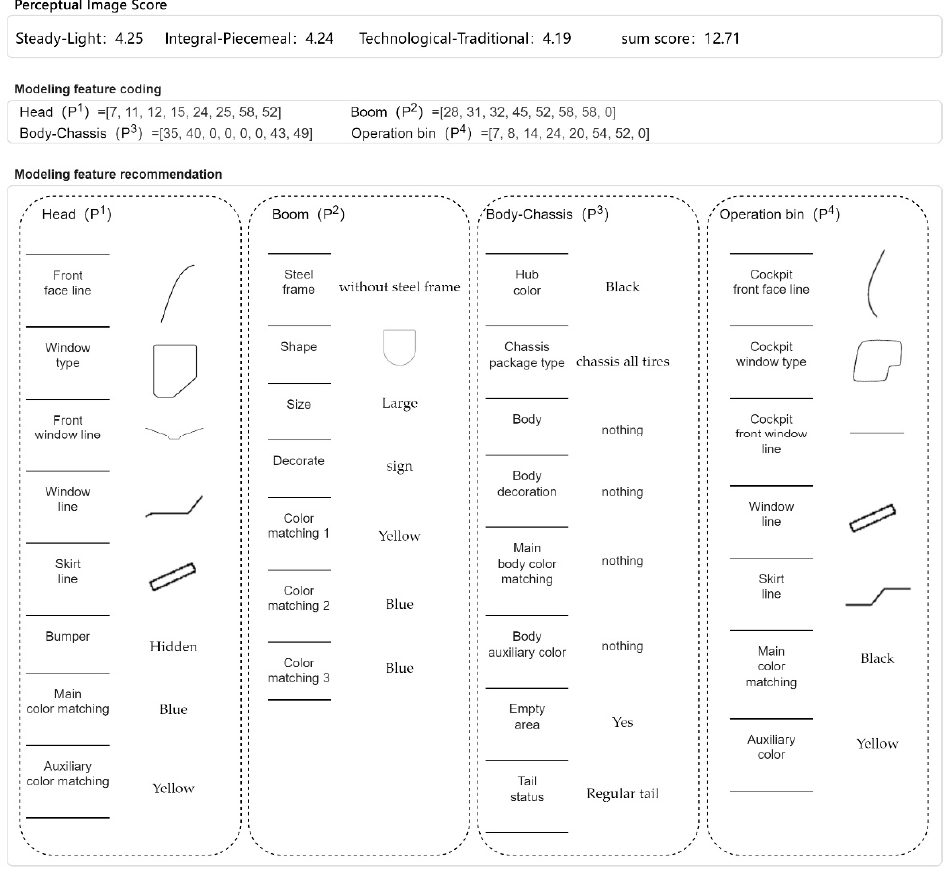
Figure 12. Modeling feature set of the optimal truck-crane design scheme.